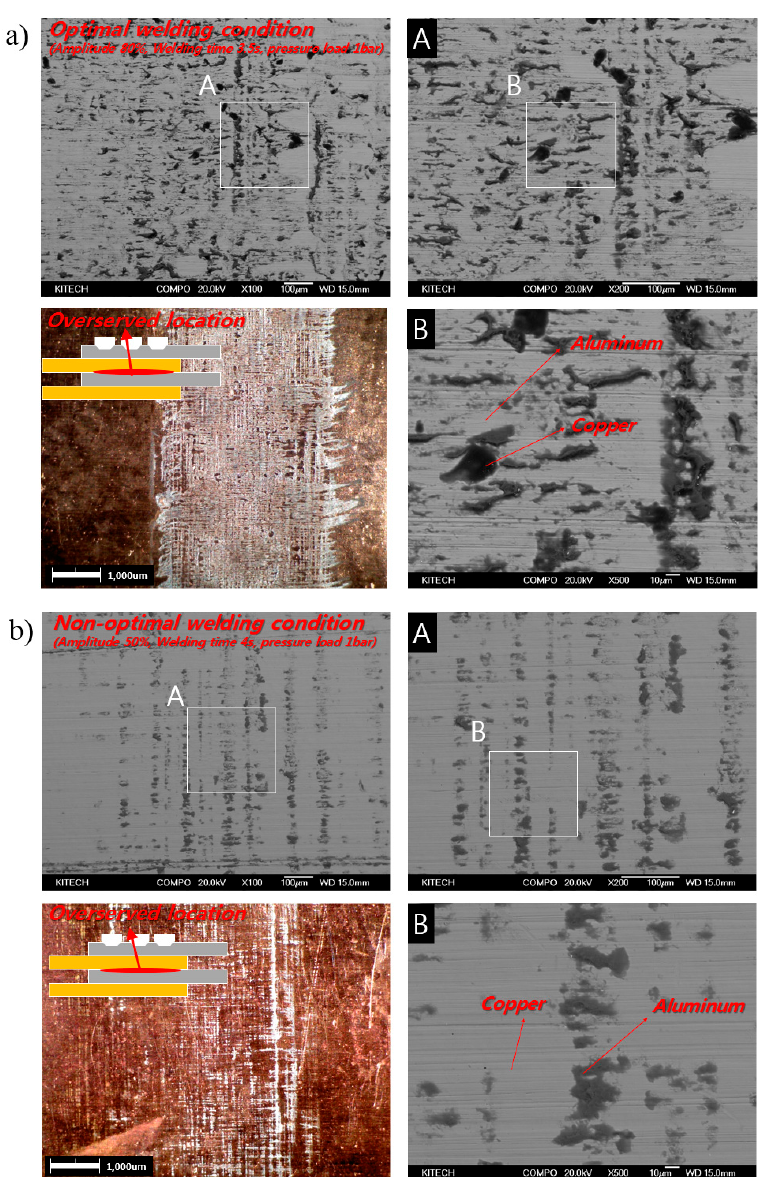
Figure 18. SEM images of fractured weld zone on the Cu surface with optimal welding conditions and non-optimal welding conditions: ( a ) optimal welding conditions, and ( b ) non-optimal welding